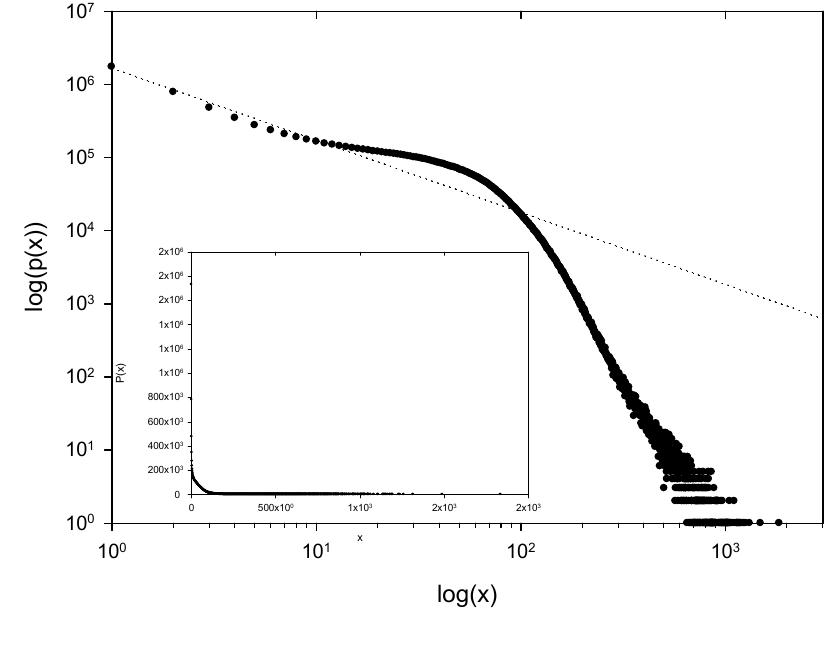
<Figure 1> Degree distribution of total agent population plotted as log-log. The inset plots the abscissa on a linear